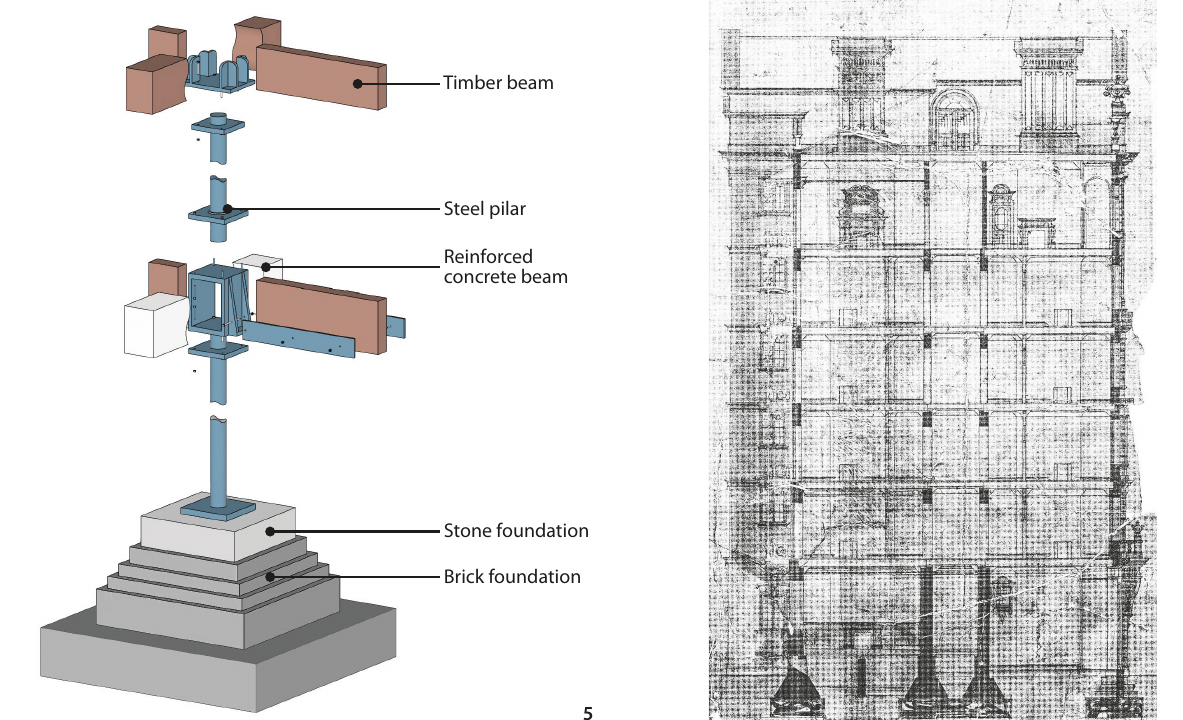
Figure 5 Steel column joints with timber and concrete beams of the China Merchants Steam Navigation Company Building (Source: the author). Figure 6 The section of the Palace Hotel (Source: Shanghai Urban Construction Archive).